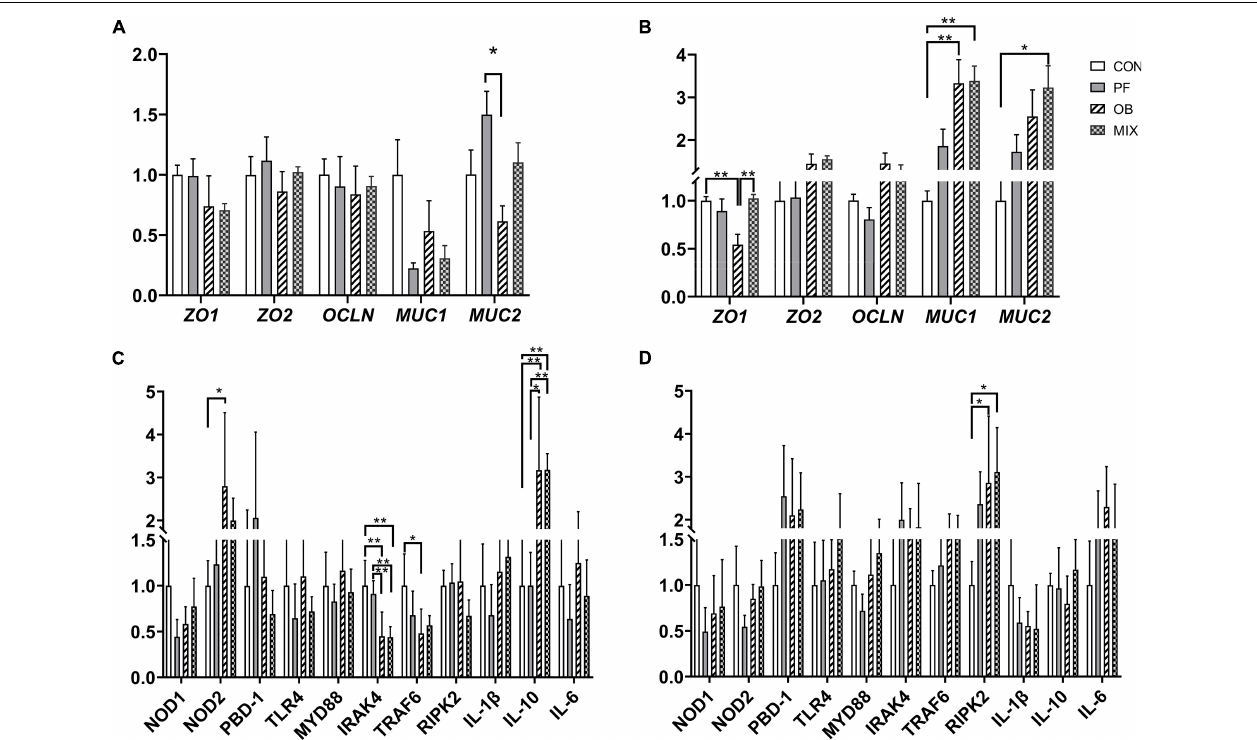
FIGURE 1 | The relative expression of intestinal barrier and immunity-related genes in the ileum and colon of pigs fed different diets. (A) The expression of genes encoding tight junction proteins and mucin in the ileal mucosa. (B) The expression of genes encoding tight junction proteins and mucin in the colonic mucosa. (C) The expression of key genes associated with TLR4 and NOD pathways in the ileal mucosa. (D) The expression of key genes associated with TLR4 and NOD pathways in the colonic mucosa. * p < 0.05, ** p < 0.01. CON, control group; PF, 15% pea-hull fiber in the diet; OB, 15% oat bran in the diet; MIX, 7.5% pea-hull fiber and 7.5% oat bran in the